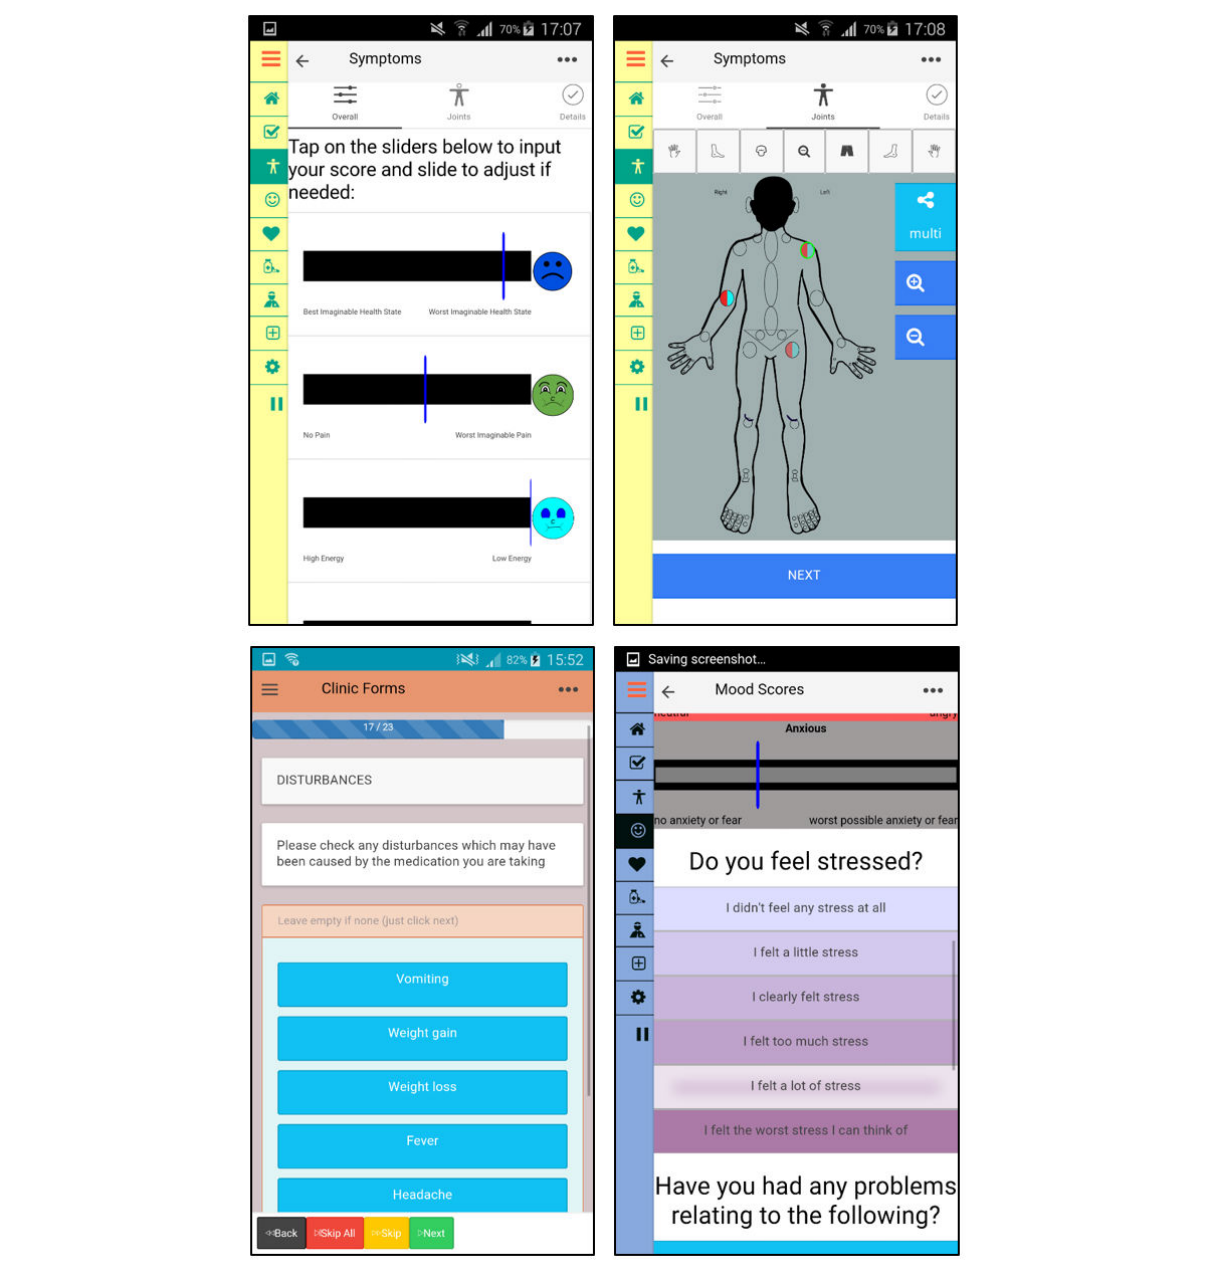
Figure 3. Screenshots of the app for monitoring symptoms, thoughts, &